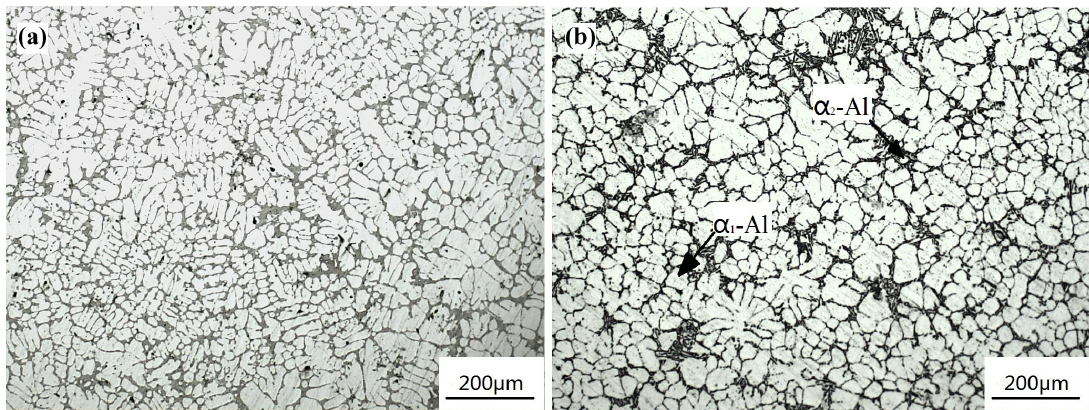
Fig. 3 Microstructures of ZL101 aluminum alloy slurry prepared by two methods (a) conventional casting; (b) serpentine channel Table 1. Processing parameters and characteristic parameter of semi-solid slurry Sample No. Curve